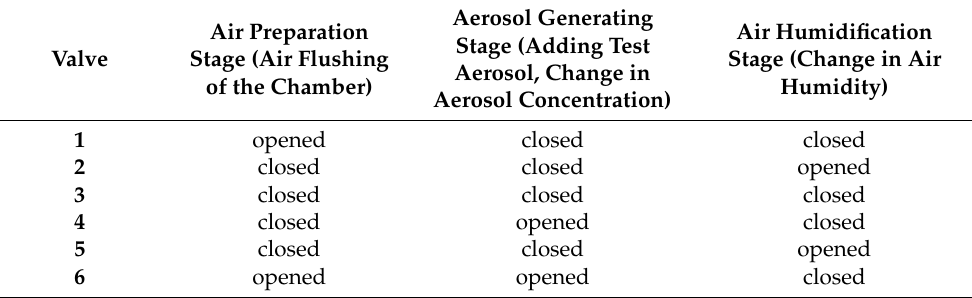
Table 1. The states of the valves in the experimental setup (Figure 3) at various stages of the